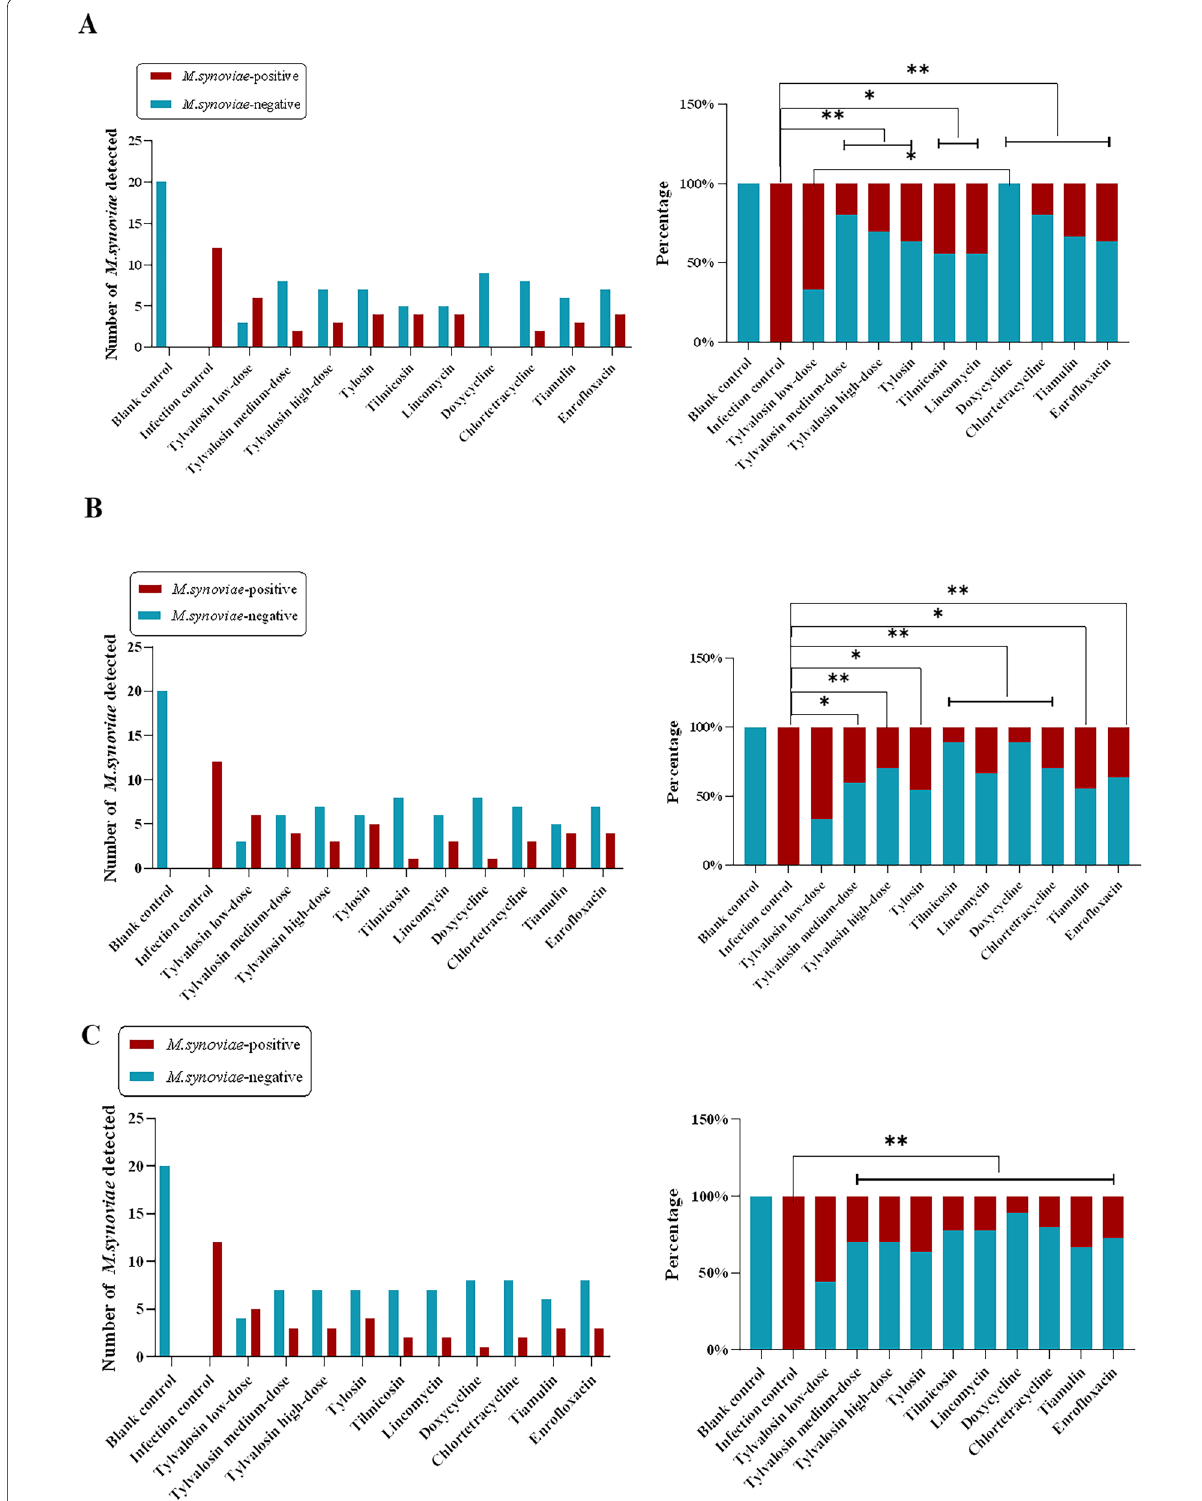
Fig. 3 Number and percentage of M. synoviae detected after drug withdrawal. A First day after drug withdrawal; B Seventh day after drug withdrawal; C Fourteenth day after drug withdrawal. Asterisks in the figures indicate significant differences (* P < 0.05; ** P <